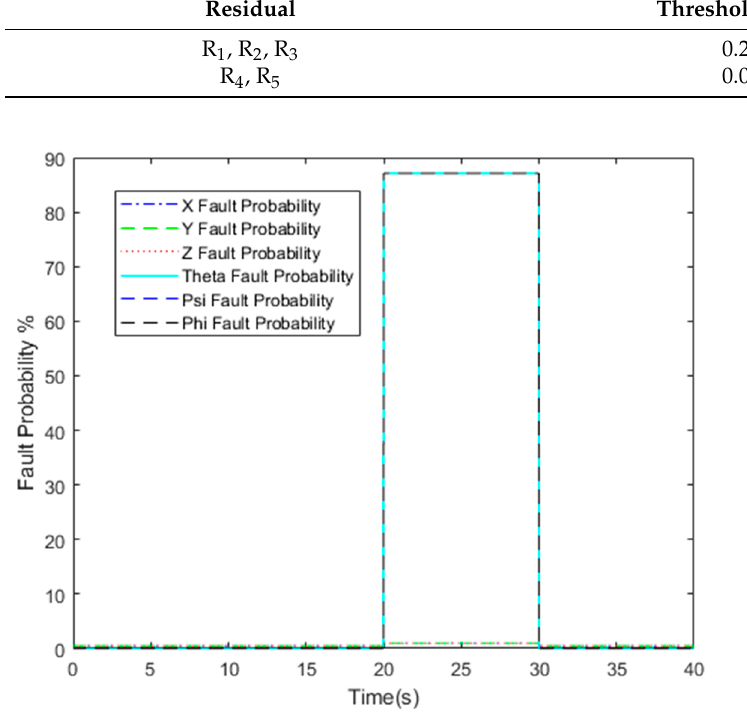
Table 2. Residual Threshold Values.